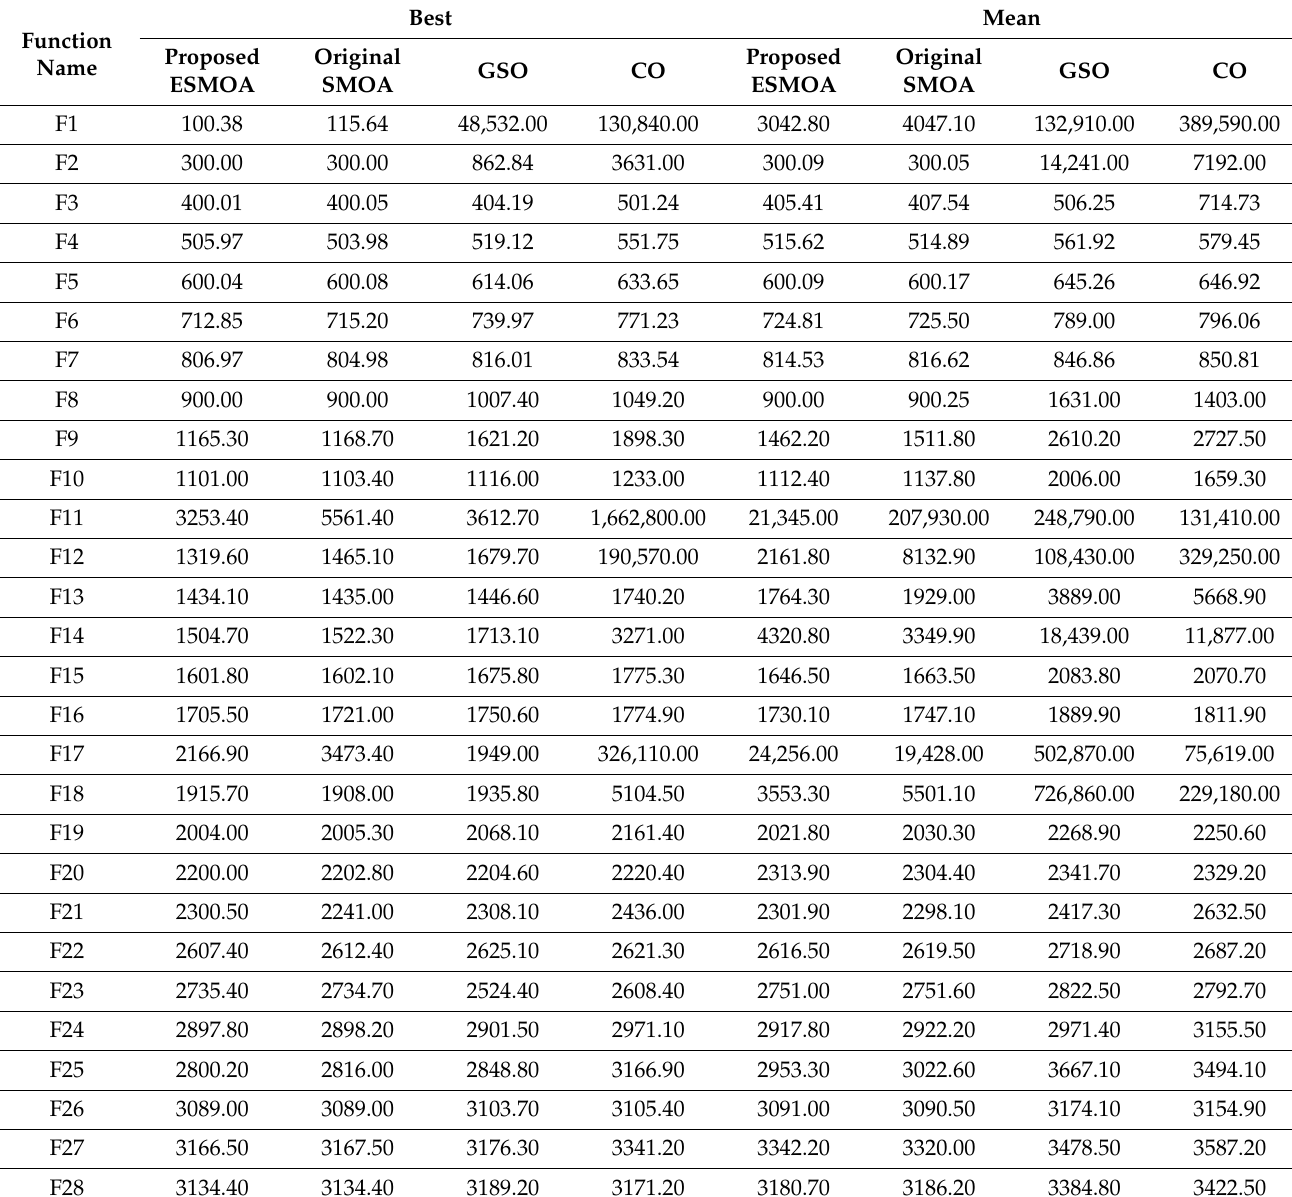
Table 1. Best and mean of the comparative algorithms for the 28 benchmark